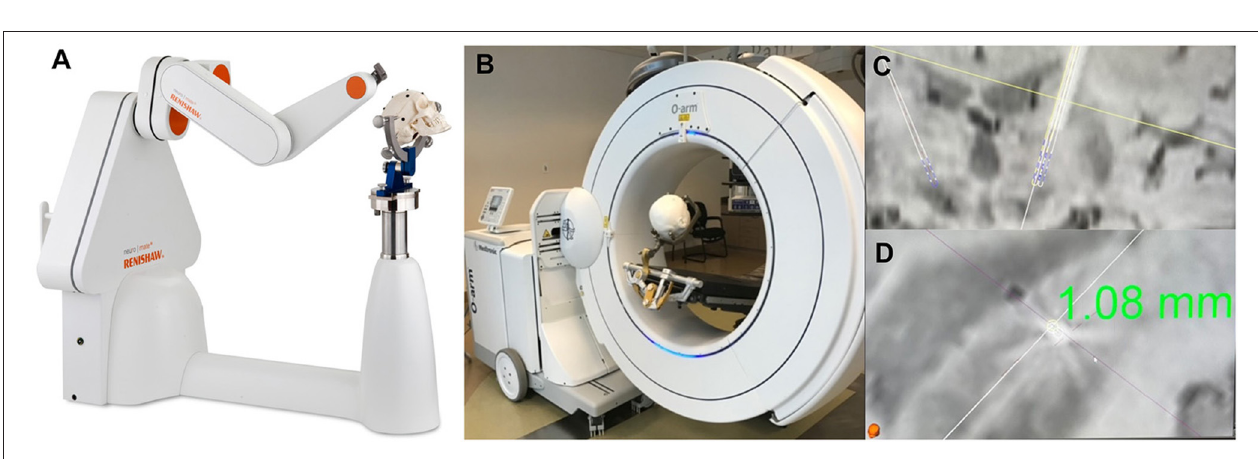
can be minimized is manually setting the frame